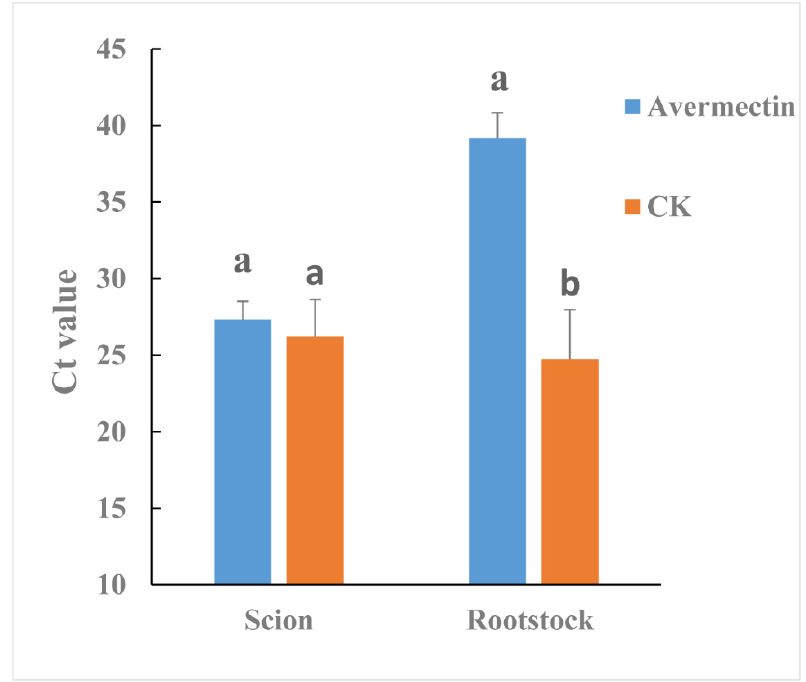
Figure 5. Effectiveness of avermectins against C Las as evaluated by a grafted-based assay. Different letters represented significantly differences at the level of 0.05 ( p ≤ 0.05).